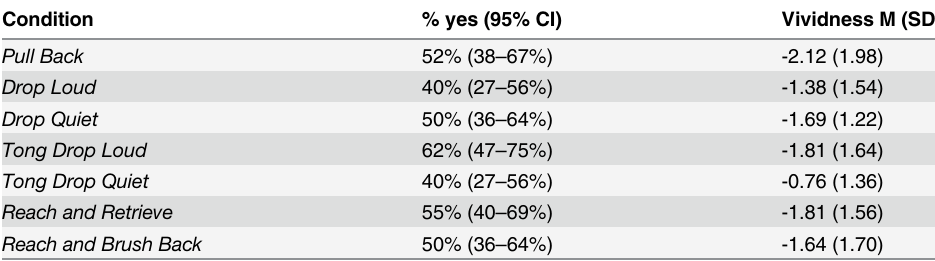
Table 1. Descriptive statistics for binary measure and vividness measure.